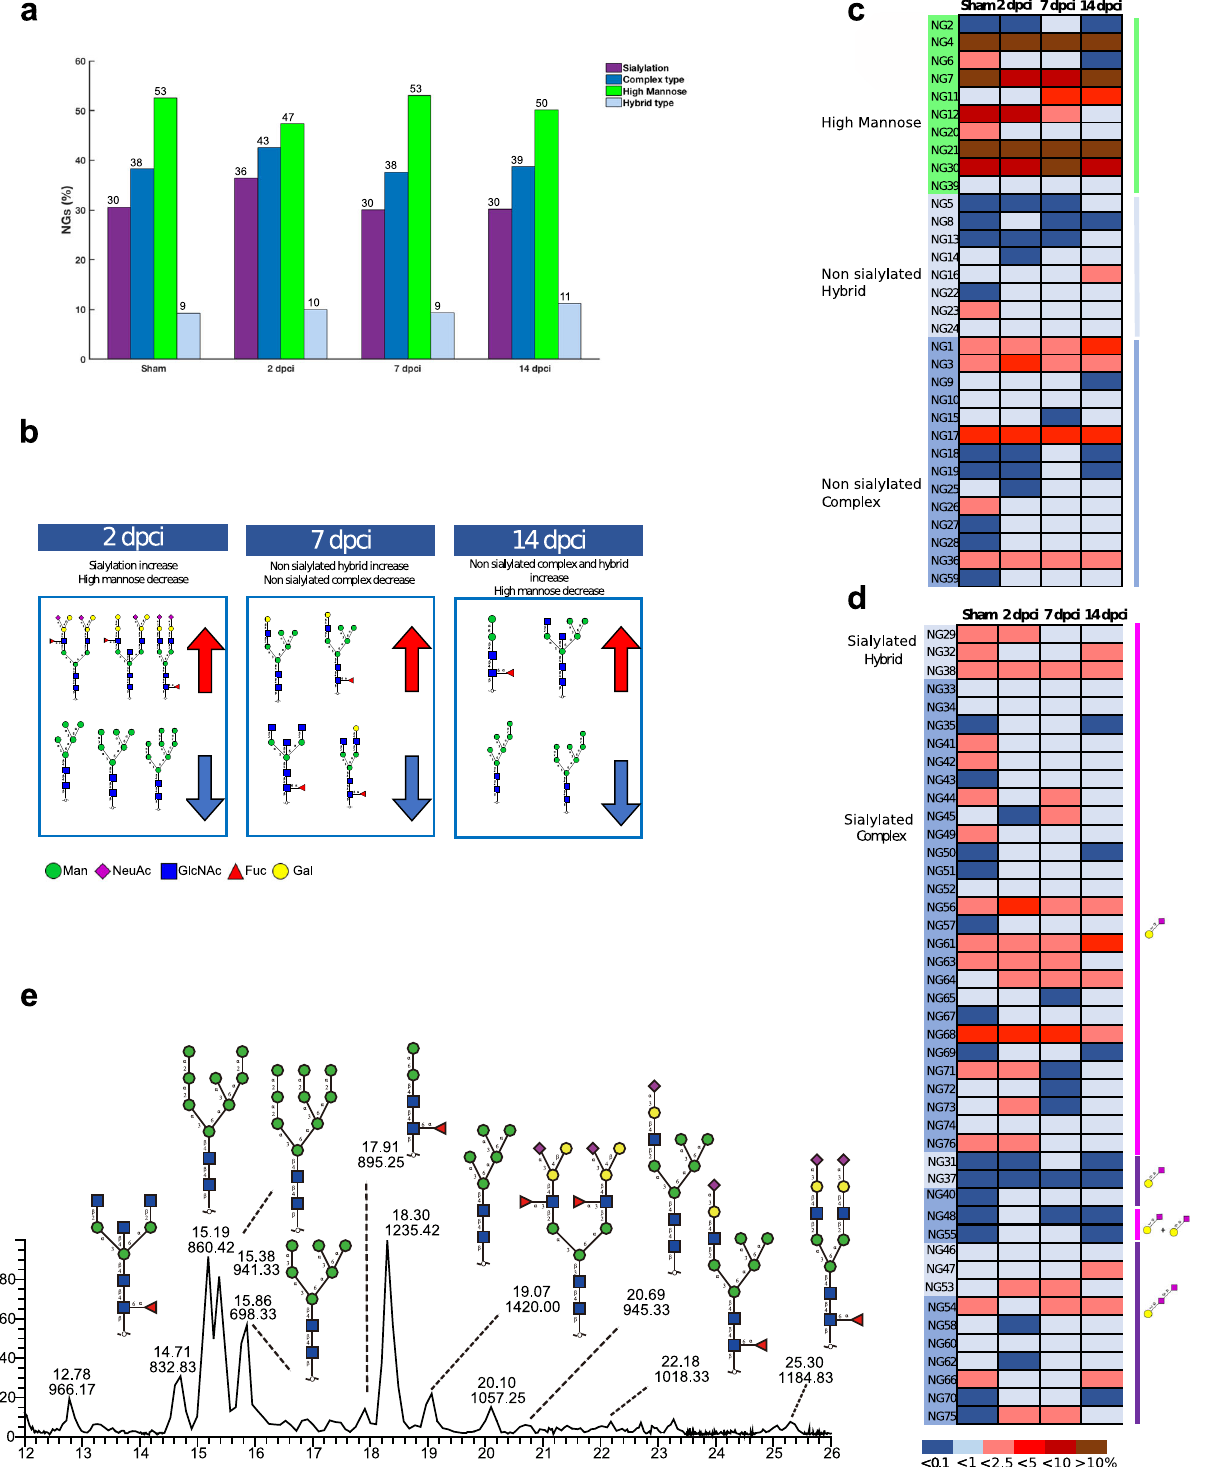
Fig. 5 Membrane N-glycan pro fi le of regenerating zebra fi sh heart established by LC-MS/MS revealed increased sialylation and a reduction in high mannose structures during the in fl ammatory phase. a Comparison of N-glycan types (complex, high mannose and hybrid) and sialylation between sham and the different regeneration phases (2, 7 and 14 dpci). The in fl ammatory phase (2 dpci) showed a 6% increase in sialylated glycans and a 5% decrease in high mannose structures compared to sham. b Summary of the main changes in N-glycans features (sialylated hybrid and complex type increase/decrease, non-sialylated hydrid and complex type increase/decrease, high mannose-type increase/decrease) showing some of the corresponding structures. c Heatmap displaying time-speci fi c relative quanti fi cation of neutral, and d sialylated N-glycans. Color intensity represents the relative abundance expressed as a percentage. e Extracted ion chromatography (EIC) showing the most abundant membrane N-glycans present in zebra fi sh heart. Results deriving from samples pooling of six animals are shown ( n = 6 animals per